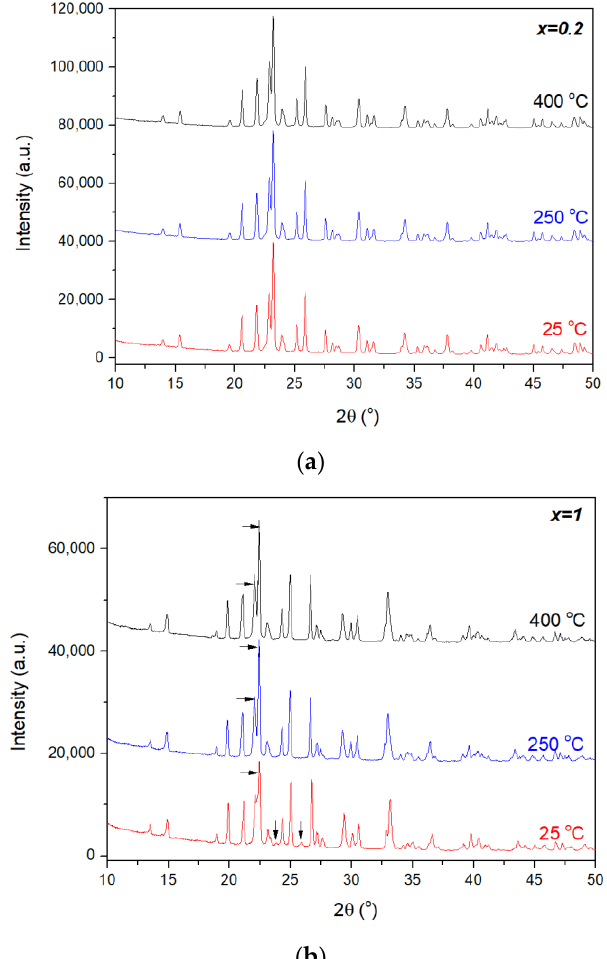
Figure 2. HT-XRPD patterns of Al 2−x In x W 3 O 12 materials for ( a ) x = 0.2 (orthorhombic) and ( b ) x = 1 (illustrating the phase transition from a monoclinic to orthorhombic structure at 250 °C). ( b ) The arrows at RT show typical features for the monoclinic system in the A 2 M 3 O 12 family, while at higher temperatures the arrows mark separation of the most intense peak into two diffraction lines, which is a feature of an orthorhombic pattern for the A 2 M 3 O 12 family.